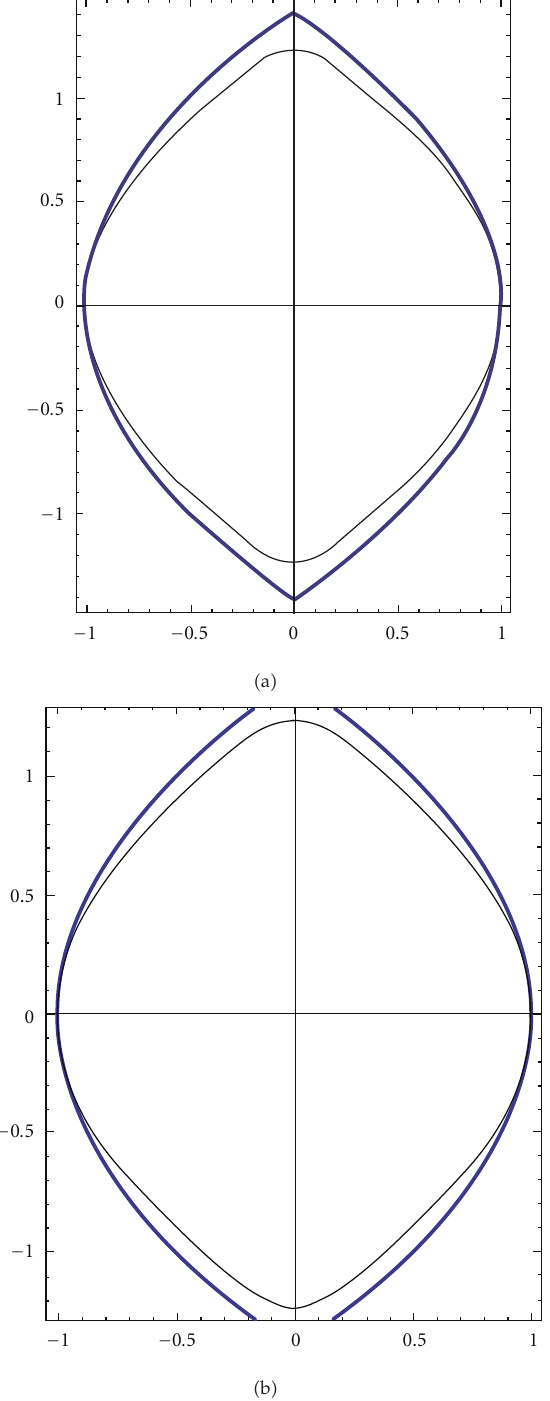
Figure 1: Comparison for the u versus ˙ u trajectory for the case of A (cid:8) 1; bold line represents the numerical solution; and black line represents the multiple-parameter Hamiltonian approach (cid:3) a (cid:4) six-parameter (cid:3) b (cid:4)